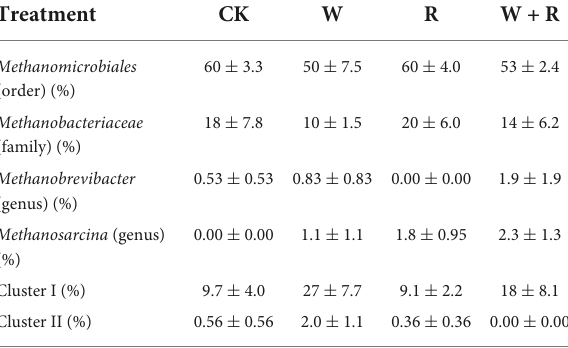
TABLE 3 ANOVA results on the response of methanogens to different climate change treatments ( p- values as compared with control).